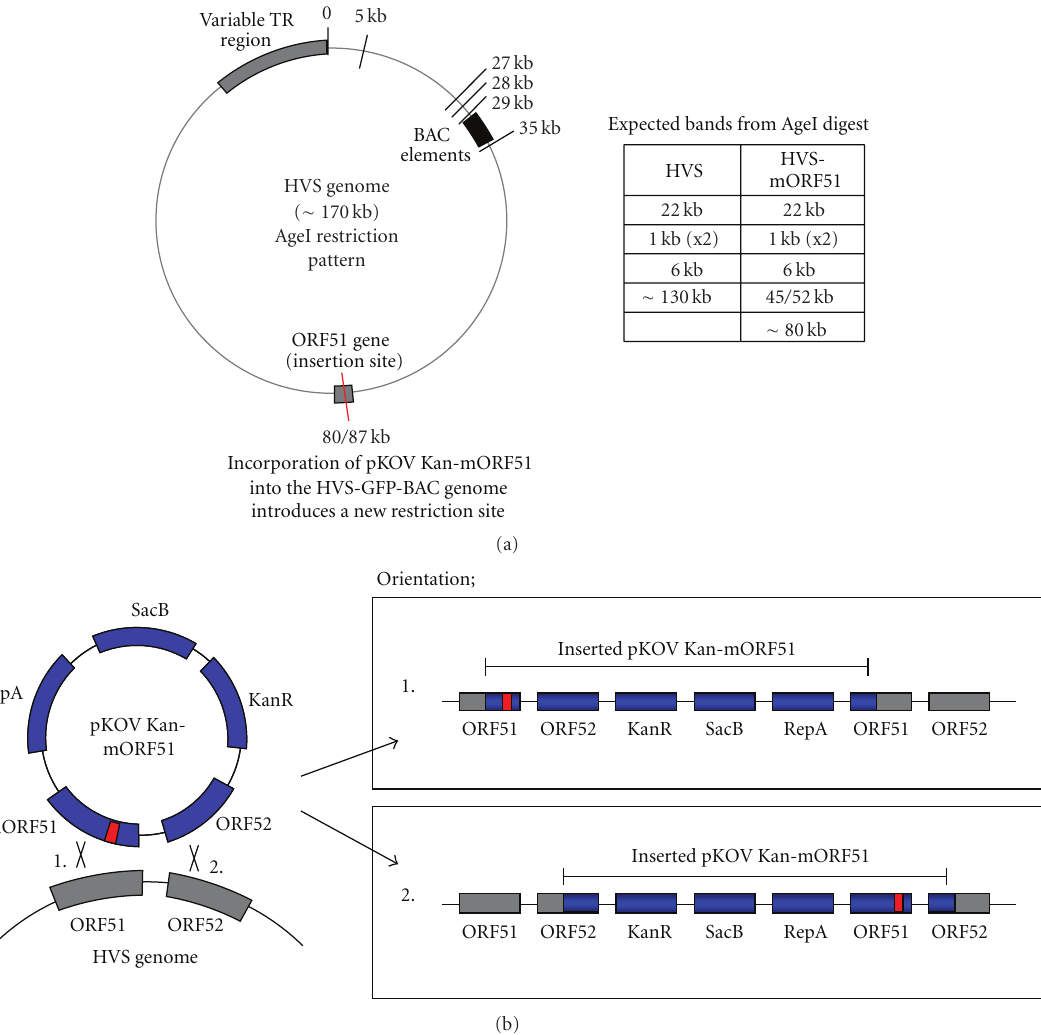
Figure 3: Possible orientations of pKOV Kan mORF51 cointegrants as seen by AgeI digest. (a) AgeI restriction map of the HVS genome. The restriction site marked in red is introduced when homologous recombination occurs between the pKOV Kan mORF51 plasmid and the complementary sequence in the viral genome. This introduced restriction site can then be used for identification of cointegrants. (b) Possible orientations of cointegrants. Depending on which homology region the reaction occurs (either 5 (cid:4) or 3 (cid:4) to the mutated ORF51 gene in pKOV Kan mORF51), cointegrants can be in one of two orientations. The mutated region containing the introduced AgeI site is shown in red. The pKOV Kan-mORF51 DNA is shown in blue, and the HVS DNA is shown in grey. The two orientations of cointegrant can be detected upon AgeI digestion analysis due to a 7kb di ff erence in the size of the ∼ 50 kb fragment (see table). The larger ∼ 80 kb fragment contains the terminal repeat (TR) region of the genome so is not suitable to detect this small di ff erence as the number of TRs is not